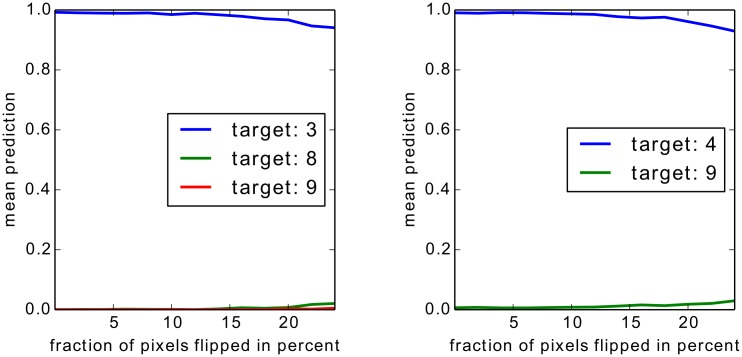
Flipping of pixels with pixel-wise decomposition score close to zero.Pixels with absolute value closest to zero are flipped first. Digit and non-digit pixels may be flipped. Pixel-wise decomposition have been computed for the true digit classes three (left) and four (right).